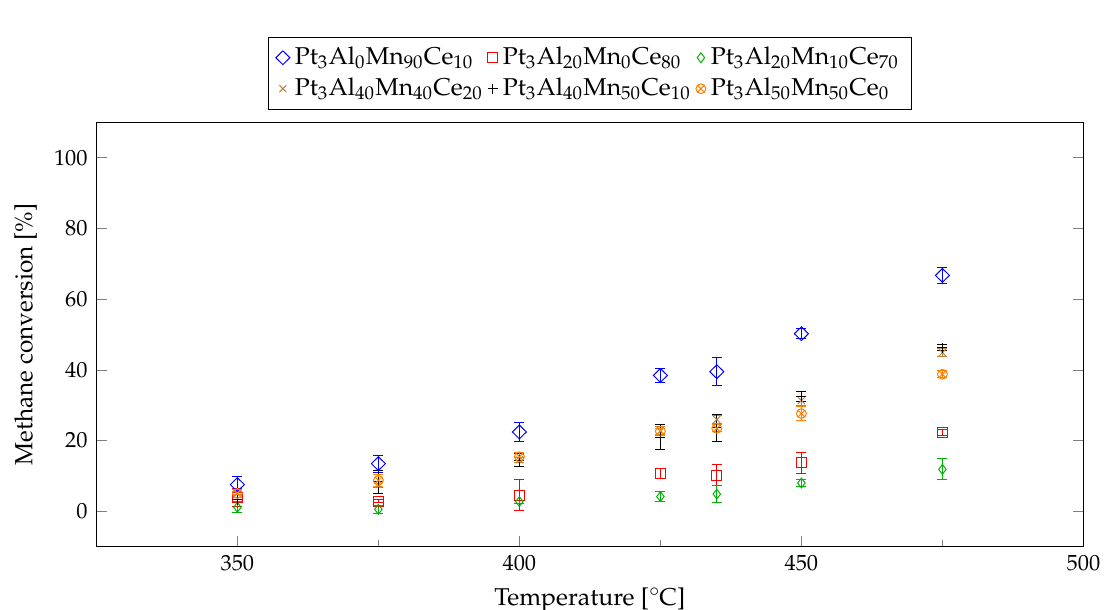
Figure 12. Methane conversion at different temperatures for selected samples from composition range Pt 3 Al a Mn b Ce c from Table 1. 12.5vol.% H 2 O, 12.5vol.% CO 2 , 9.0vol.% O 2 , 0.25vol.% CH 4 , 0.055vol.% CO, 0.012vol.% NO, 0.004vol.% NO 2 , 0.001vol.% SO 2 , balance He, WHSV = 36,000mL/ ( gh ) . Error bars represent standard deviation ( n = 3) as given by Equation 2.